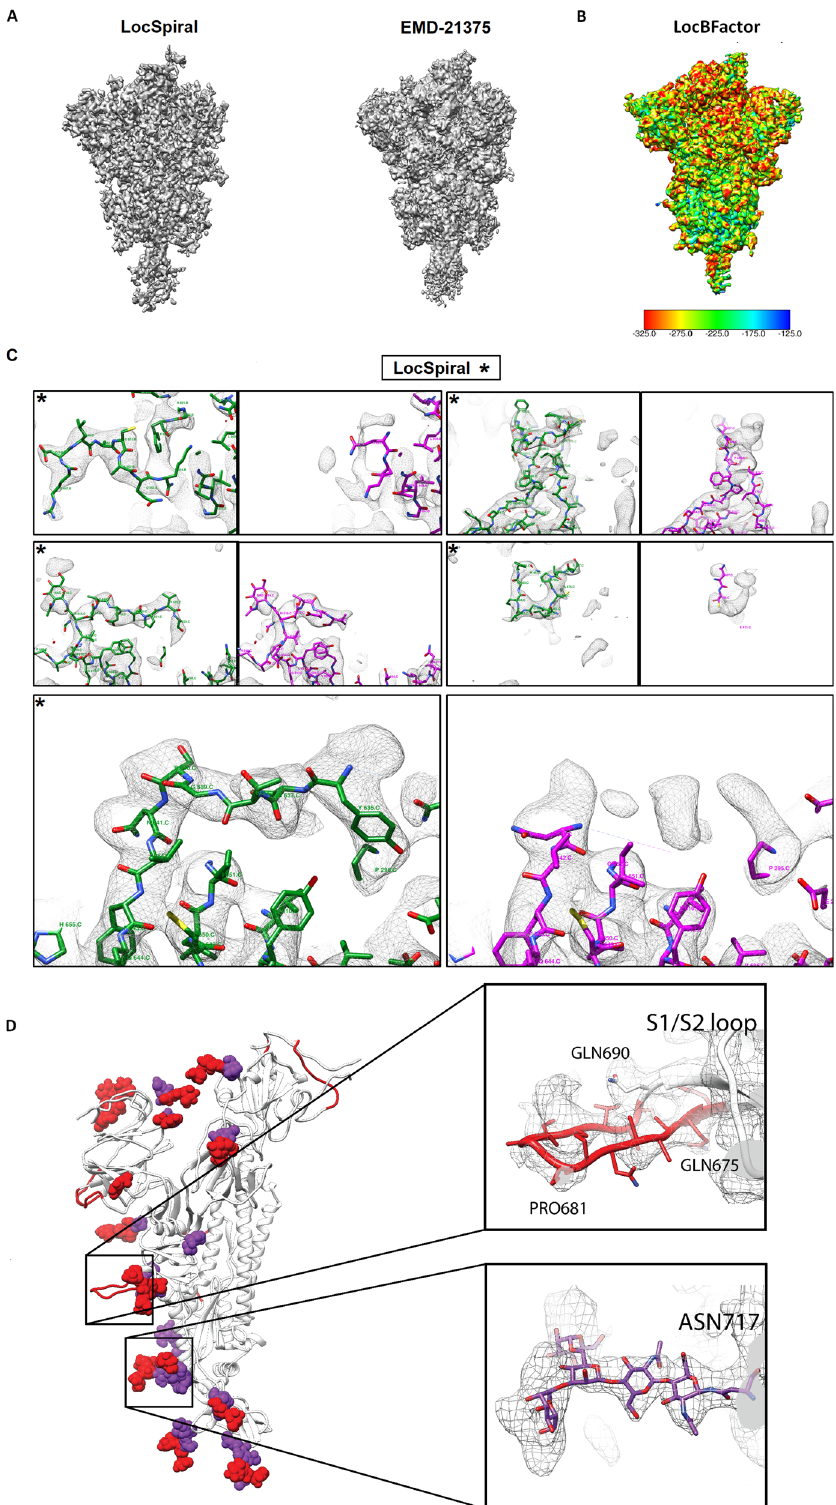
Fig. 5 Results obtained by LocSpiral, LocBFactor and improved atomic model for EMD-21375 SARS-CoV-2 sample. A Map obtained by LocSpiral approach (left) compared with the map as deposited in EMDB for EMD-21375. B B -factor maps to be used for sharpening (slope of the local Guinier plot multiplied by 4) obtained by LocBFactor approach for EMD-21375. The B -factor ranges between [ − 325.0, − 125.0] Å 2 . C Visual examples of map regions corresponding to EMD-21375 that could be further modelled after processing the corresponding un fi ltered and unsharpened map with LocSpiral approach. On the left and marked with asterisks, we show the LocSpiral maps with the improved atomic models in green, and on the right the deposited EMD-21375 map with the PDB 6vsb in magenta. D In white, PDB 6vsb with traced parts of the glycan proteins marked with purple spheres. In red, additional parts that could be traced using LocSpiral map. Inside the black squares, zoomed views of two glycan proteins that could be further modelled.